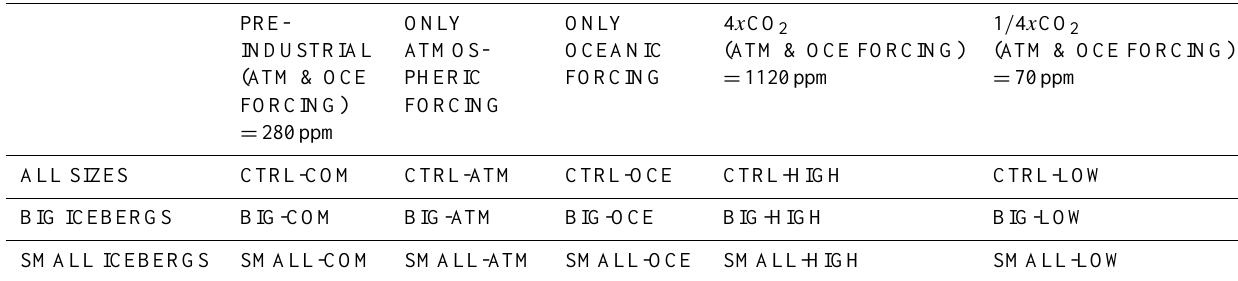
Table 1. Performed experiments. PRE- ONLY ONLY 4 x CO 2 1 / 4 x CO 2 INDUSTRIAL ATMOS- OCEANIC (ATM & OCE FORCING) (ATM & OCE FORCING) (ATM & OCE PHERIC FORCING FORCING) FORCING = 280ppm ALL